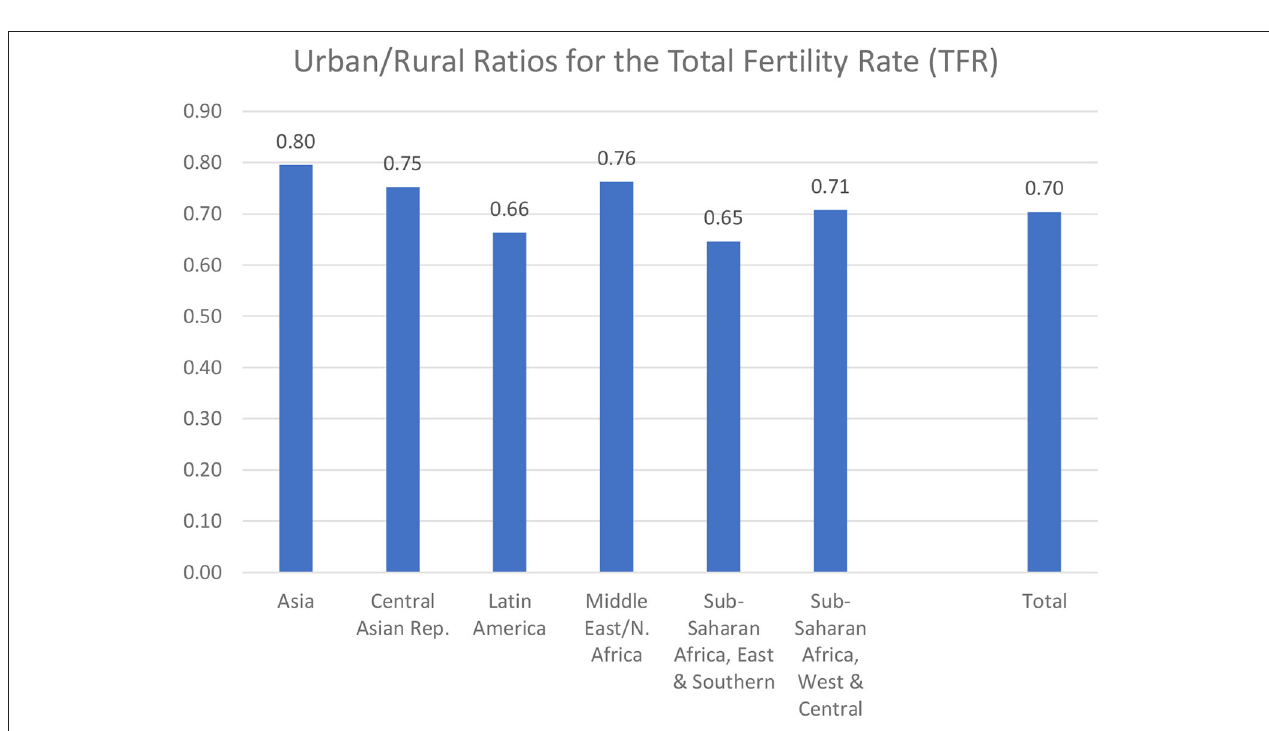
FIGURE 7 | Urban/rural ratios for the Total Fertility Rate (TFR).